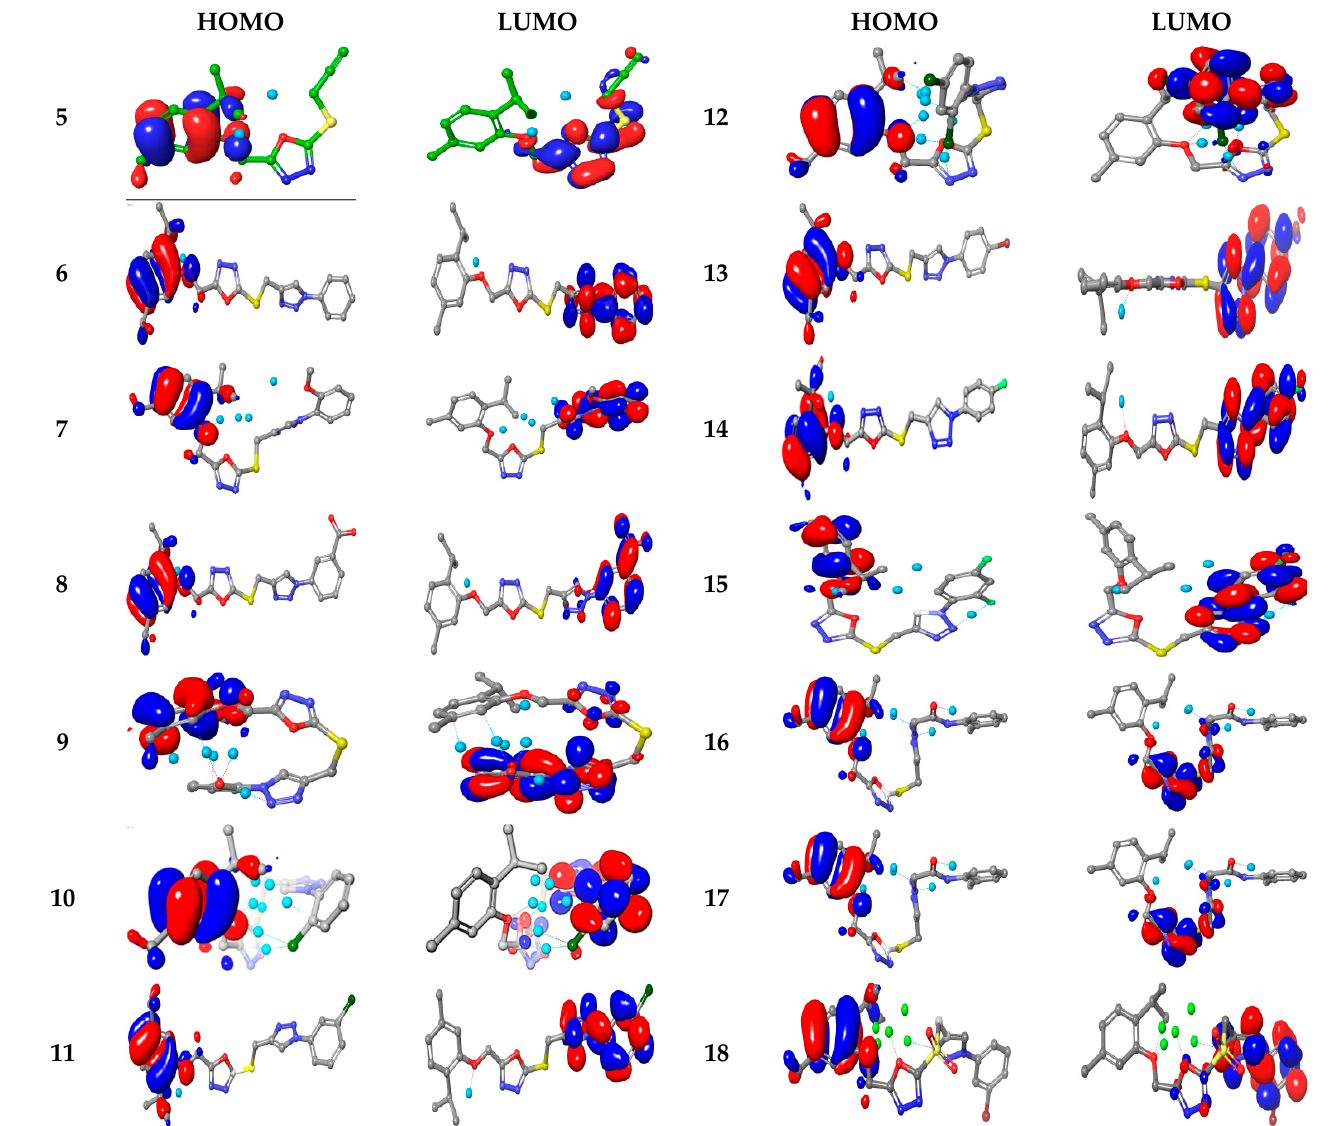
Figure 2. Ground state charge density of FMOs of thymol derivatives. Molecular Electrostatic and Ionization Potential Maps Table 5. The calculated energy for 5 – 18 To explore the reactivity of synthesized hybrids, molecular electrostatic potential (MEP) was measured experimentally by diffraction approaches [35]. This property dis-